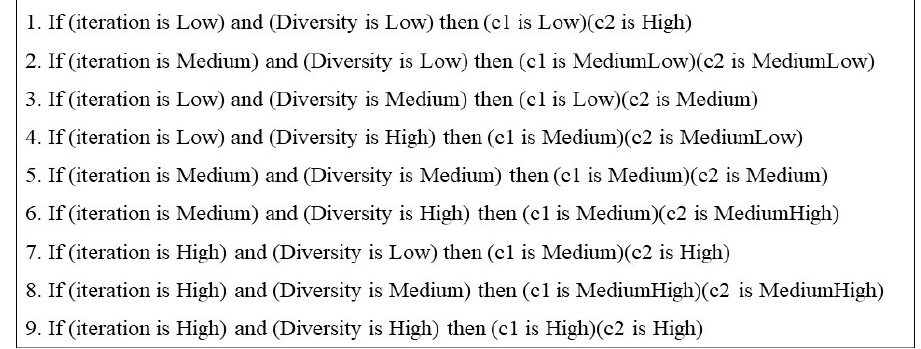
Figure 6. Fuzzy rules proposed for the third fuzzy system.